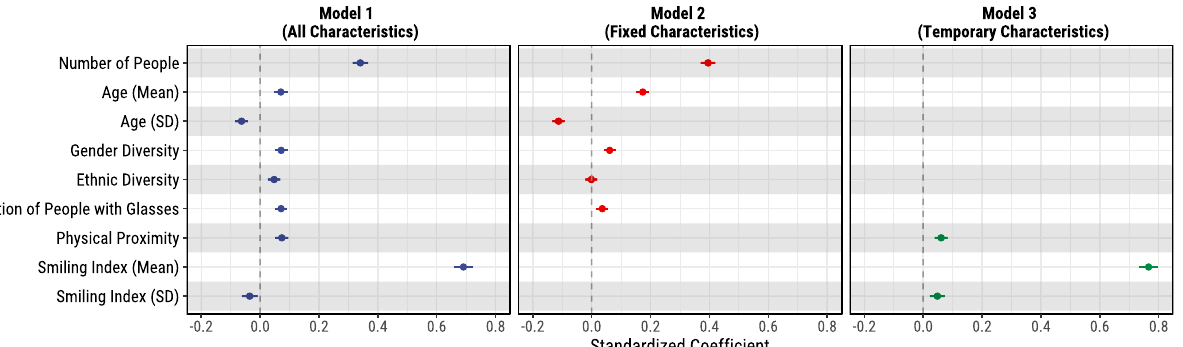
Figure 2. Coefficient plots of logistic regression models using escaped? (binary variable indicating whether the group escaped) as a dependent variable and the group characteristics as independent variables. The error bars represent 95% confidence